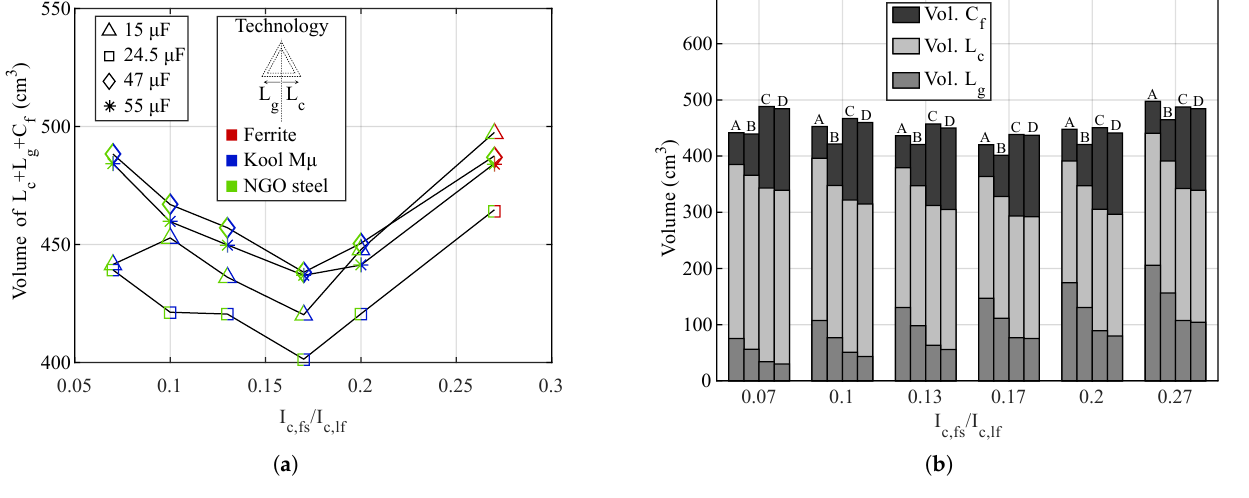
Figure 6. Total filter volume: L c + L g + C f , as a function of I c , f / I c , lf , for different C f . ( a ) Results s identifying inductor technology. ( b ) Individual component volumes, where each bar represents an analyzed value of C f , in ascending order: (A) 15 µ F; (B) 24.5 µ F; (C) 47 µ F; (D) 55 µ F. The value of I c , f / I c , lf = 17% minimized filter volume, which corresponds to a ∆ I of s approximately 28% of the peak value of the sinusoid. The obtained value of L c = 0.6 L